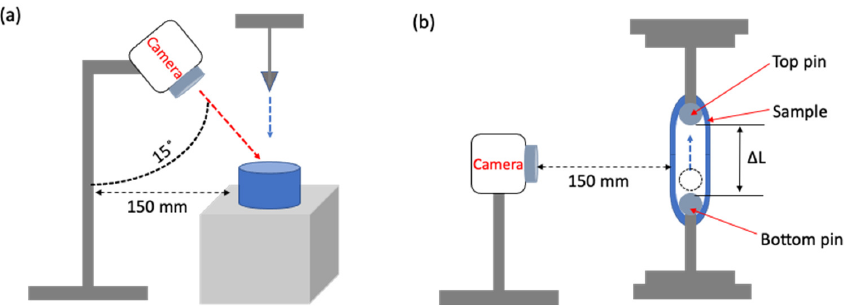
Figure 12. Schematic diagram of an image acquisition system for ( a ) penetration test, and ( b ) ring tensile test.